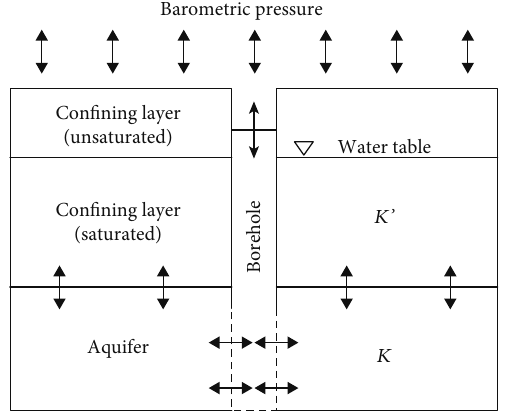
Figure 8: Sketch showing the groundwater fl ow in response to varied barometric pressure, modi fi ed from Wang and Manga [19]. K ′ is the vertical hydraulic conductivity of the aquitard, and K is the hydraulic conductivity of the